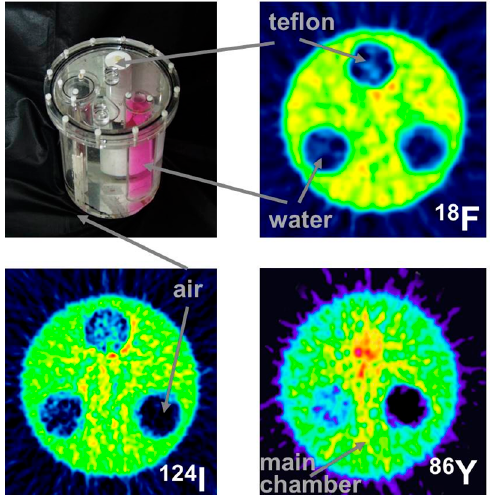
Figure 6. Reconstructed images perpendicular to the central axis of the three-rod phantom, which was filled with 18 F, 124 I or 86 Y (for further details, see the text).